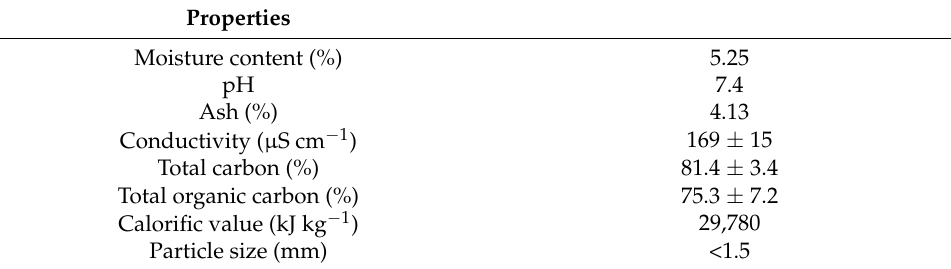
Table 1. Selected properties of wood-derived biochar